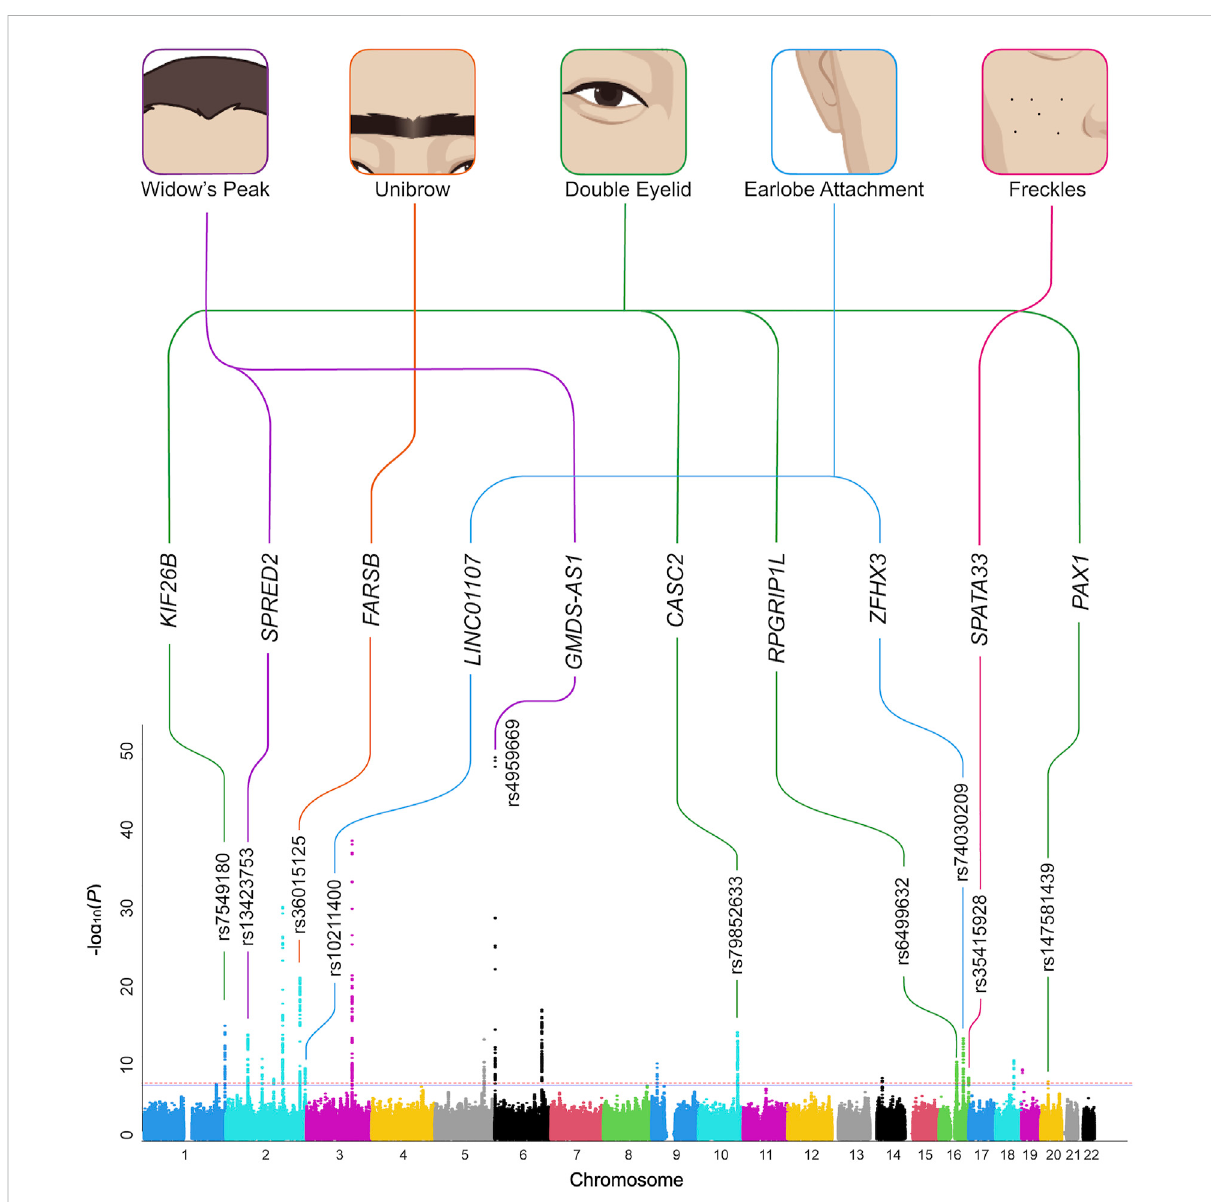
FIGURE 1 Overview of the GWAS results. The fi ve aesthetic facial traits studied in the Chinese study sample (top) are connected with the candidate genes identi fi ed in regions with novel genome-wide signi fi cant associations. The GWAS results of the fi ve traits were summarized on a single composite Manhattanplot(bottom).ThersIDoftheSNPwiththesmallest p -valueatthetopofeachassociationpeakisgiven.GWAS,genome-wideassociation study. SNP, single nucleotide